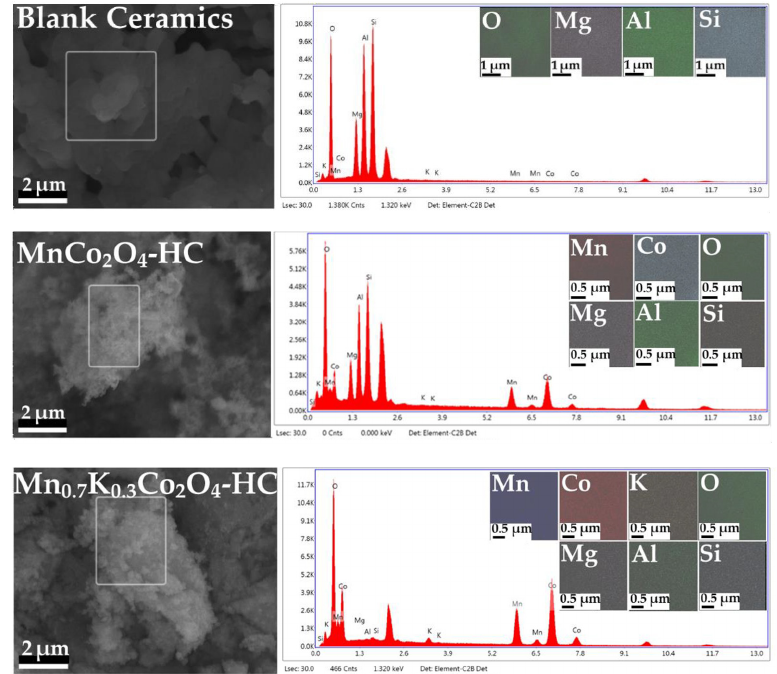
Figure 5. EDS result of elemental distribution on monolith catalysts and blank ceramics.